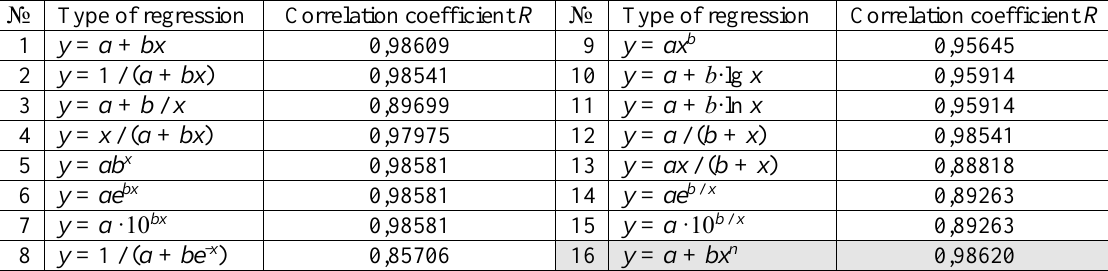
The results of the regression analysis of the dynamics of wear and tear of garbage trucks in the Khmelnytskyi